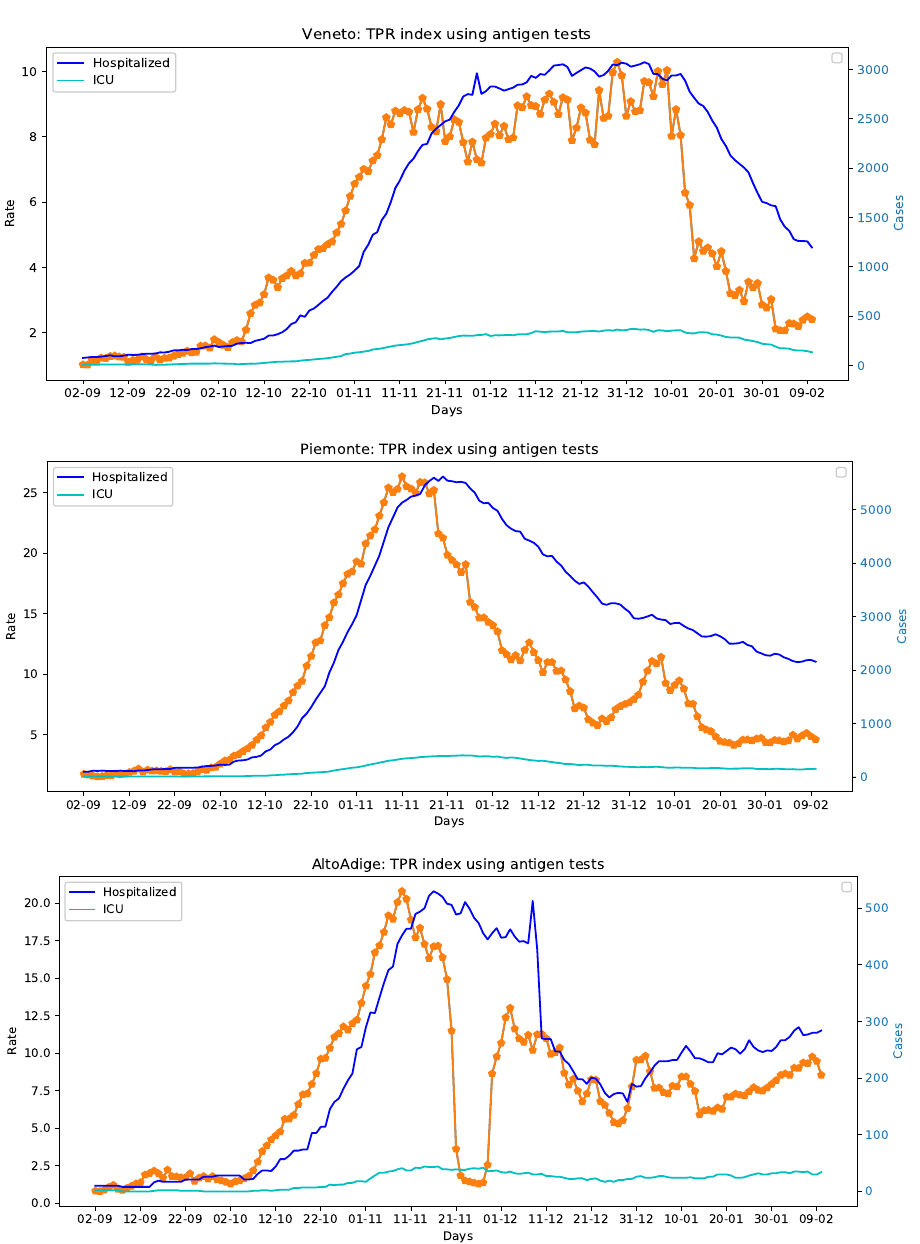
Figure 2. The TPR index (orange dotted lines) and hospitalized patients time series of Toscana, Veneto, Piemonte, and Alto